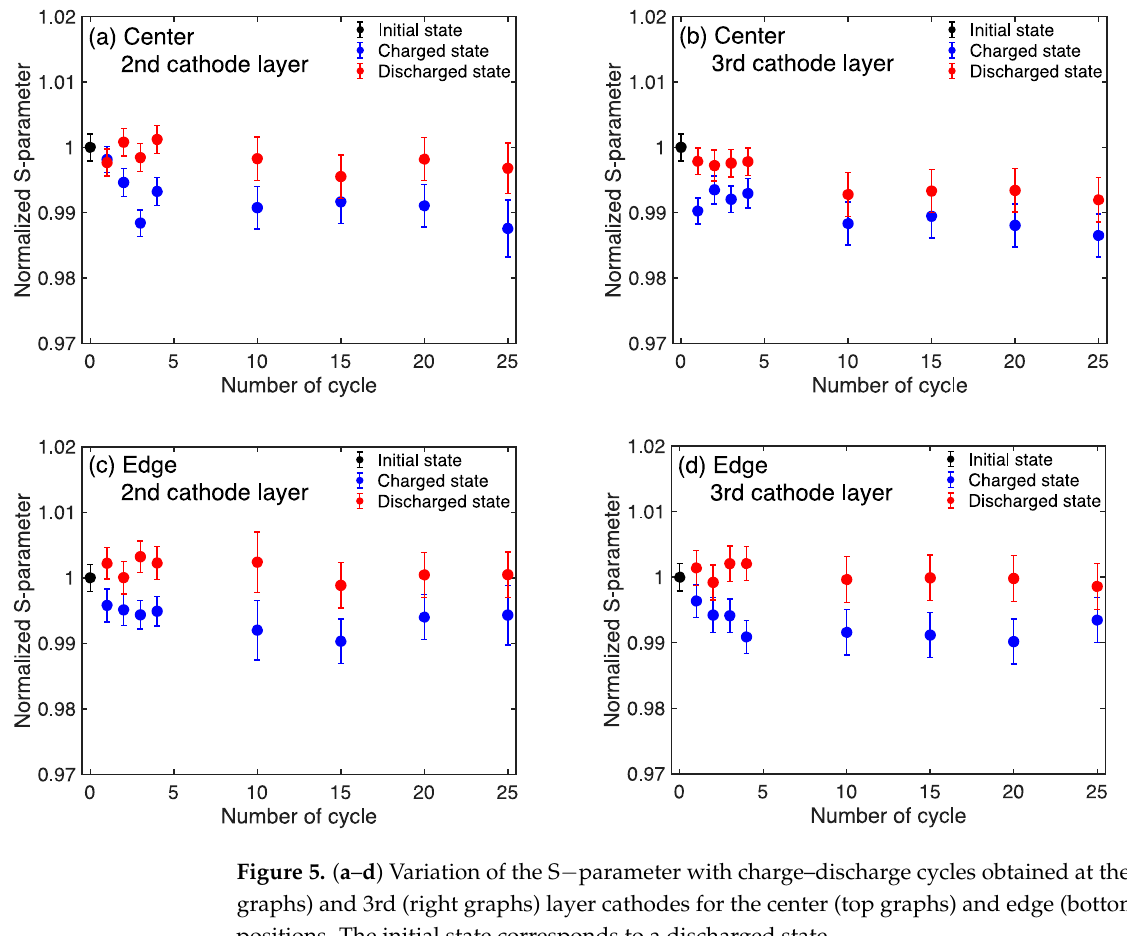
Figure 5. ( a – d ) Variation of the S − parameter with charge–discharge cycles obtained at the 2nd (left graphs) and 3rd (right graphs) layer cathodes for the center (top graphs) and edge (bottom graphs) positions. The initial state corresponds to a discharged state.